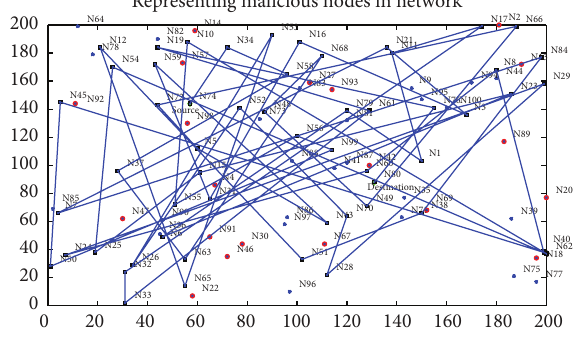
Figure 3: Route finding based upon STKF.